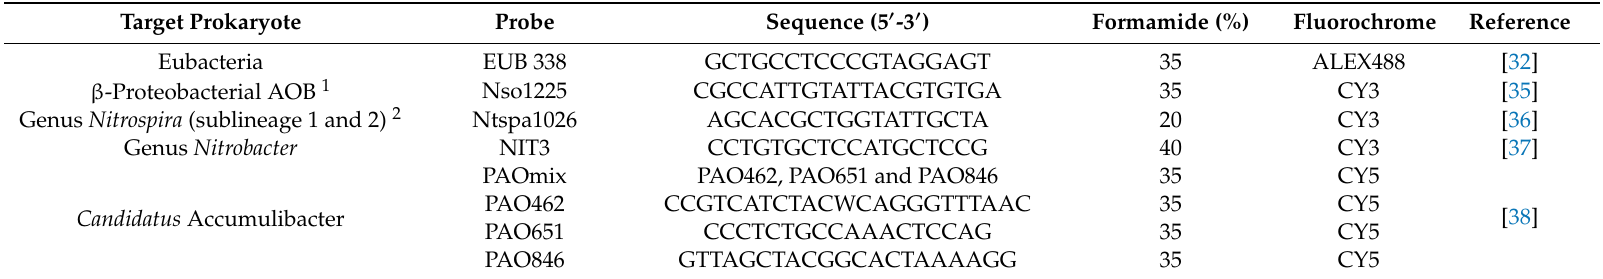
Table 4. Oligonucleotides Used for